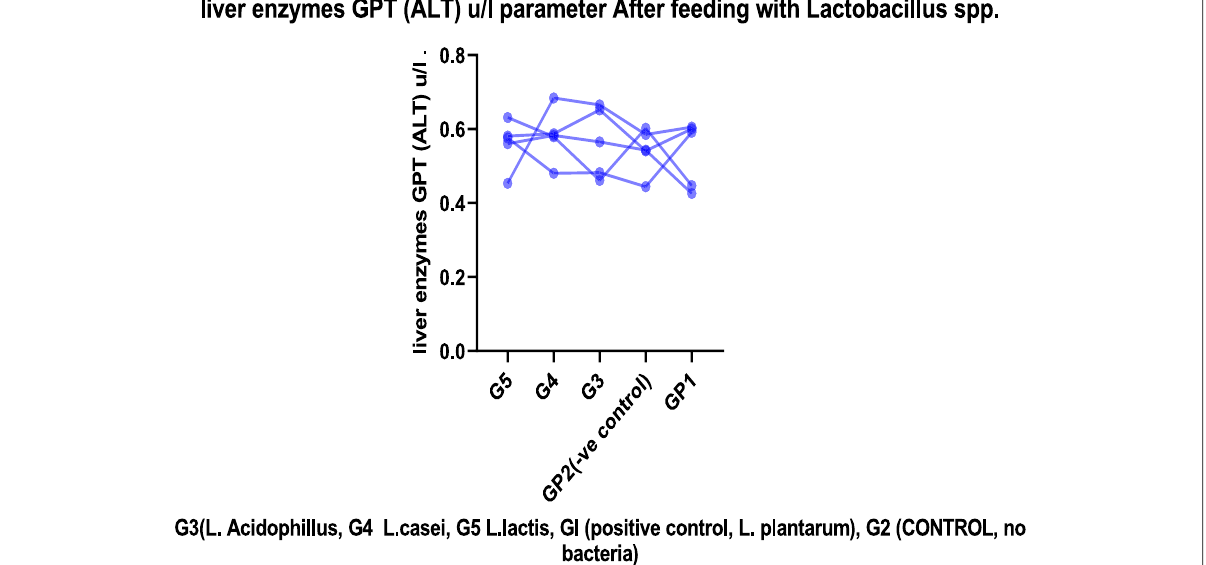
Fig. 5 Represent liver enzymes GPT (ALT) μ /l parameter before after feeding with Lactobacillus